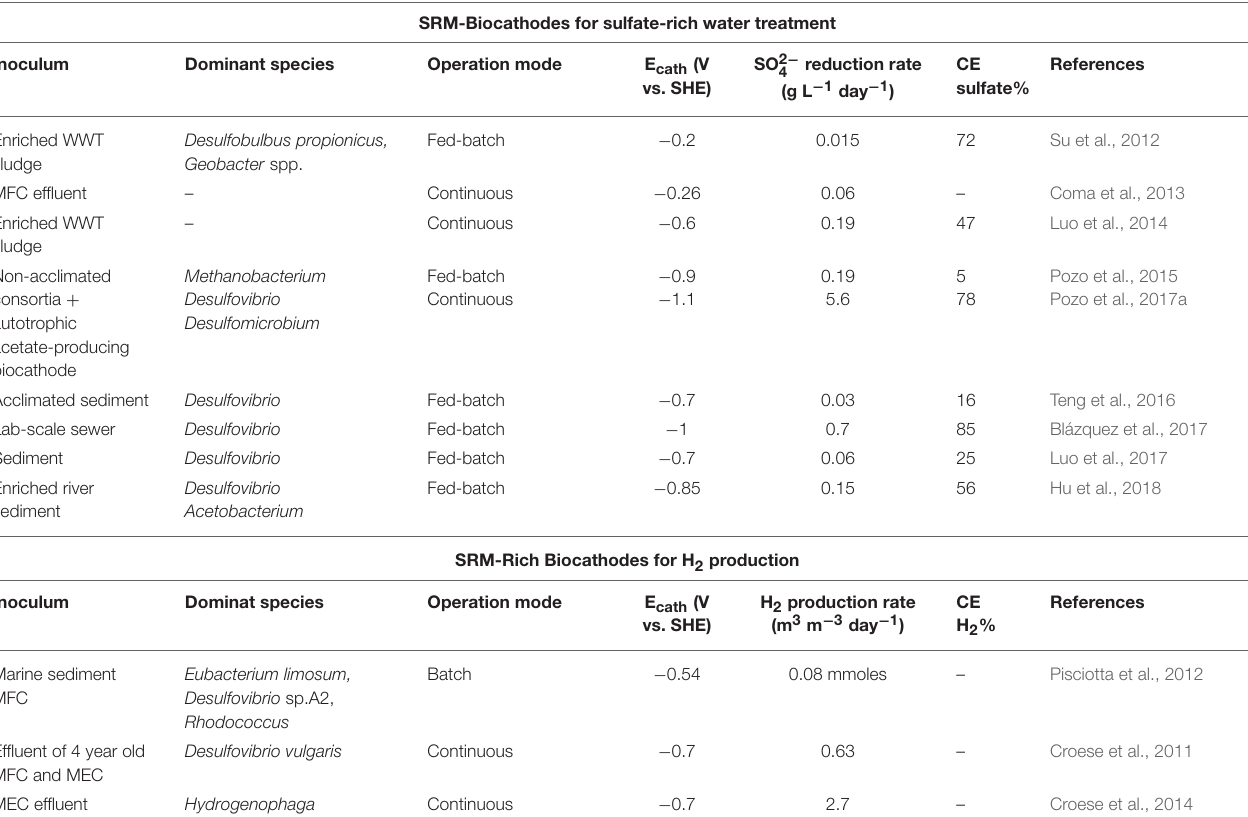
TABLE 1 | Overview of mixed-community electroautotrophic SRM-based biocathodes for sulfate removal and H 2 production. SRM-Biocathodes for sulfate-rich water